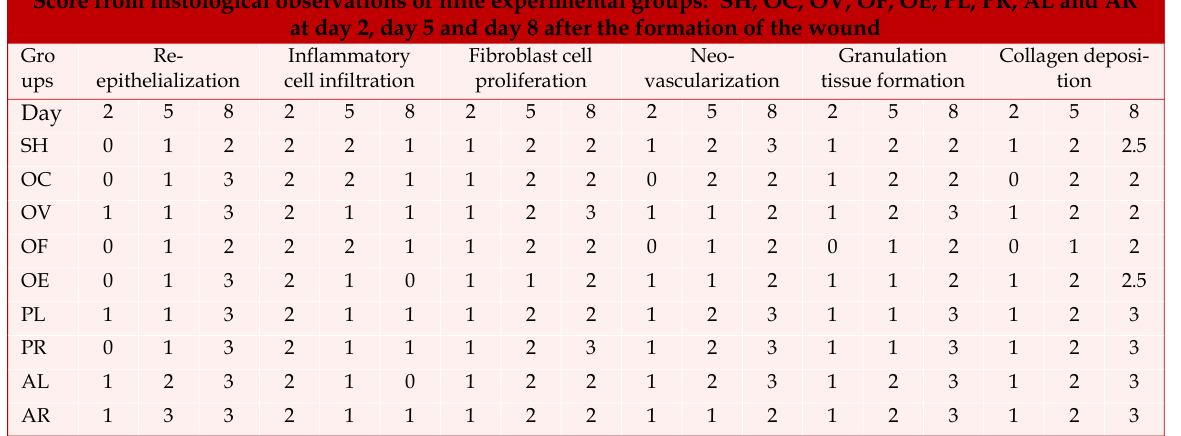
Score from histological observations of nine experimental groups: SH, OC, OV, OF, OE, PL, PR, AL and AR at day 2, day 5 and day 8 after the formation of the wound Gro Re- Inflammatory ups epithelialization cell